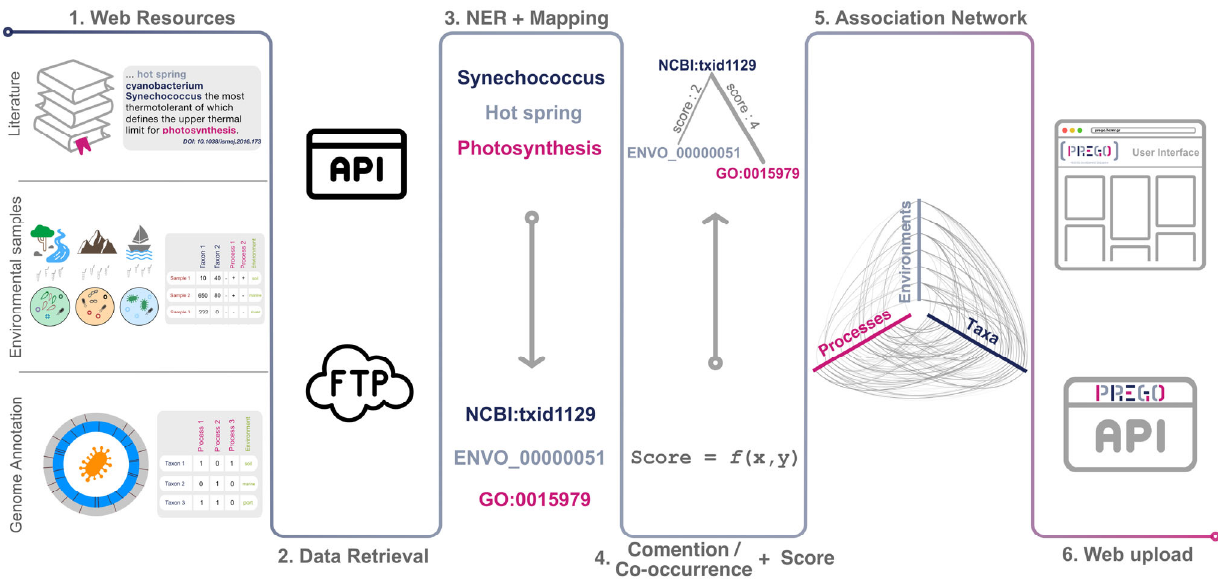
Figure 1. PREGO analysis methodology: PREGO periodically retrieves three distinct types of data from open access resources. Scientific text, environmental sample data, and genomic